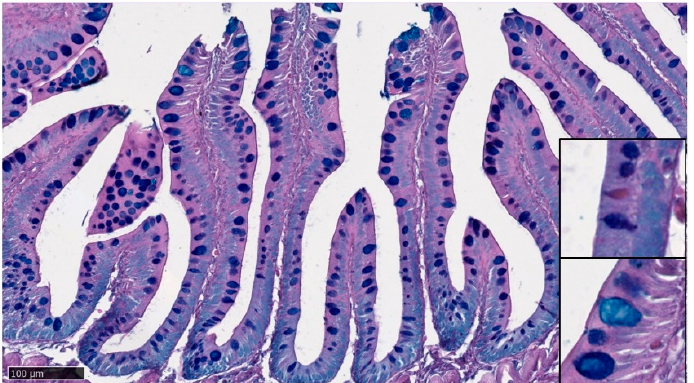
Figure 10. AB-PAS stained section showing the presence of a heterogenous populations of goblet cells. Most mucus-secreting cells produced a mixed secretion (PAS-AB positive-dark blue cells), some secreted acid mucins (AB positive-light blue cells), and a smaller amount produced neutral mucus (PAS positive-magenta cells).